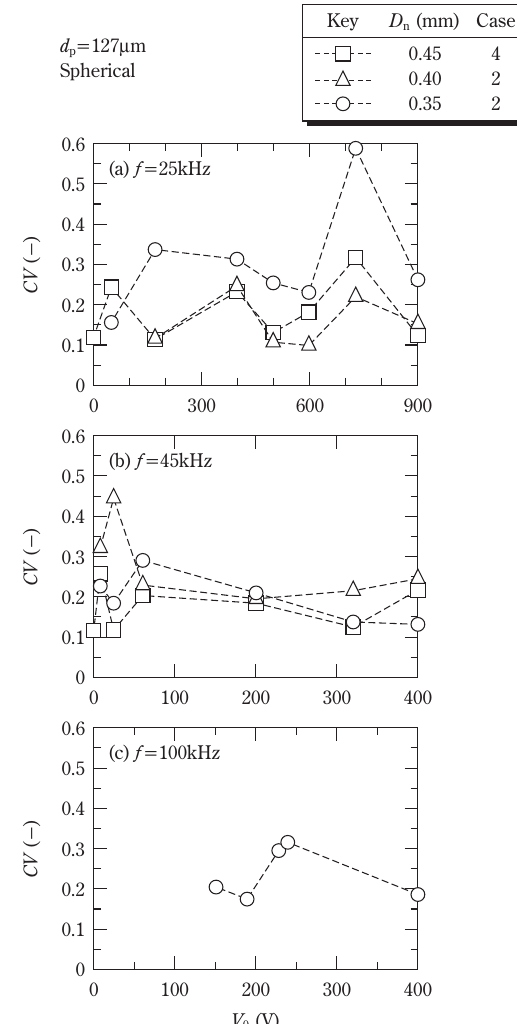
Fig. 7 Relationships between coefficient of variation, CV , vs. applied voltage V